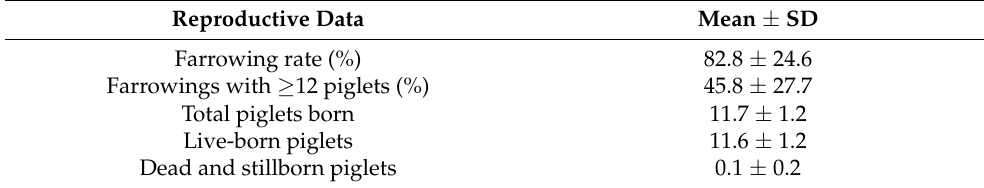
Table 1. Reproductive data of 468 inseminated sows.